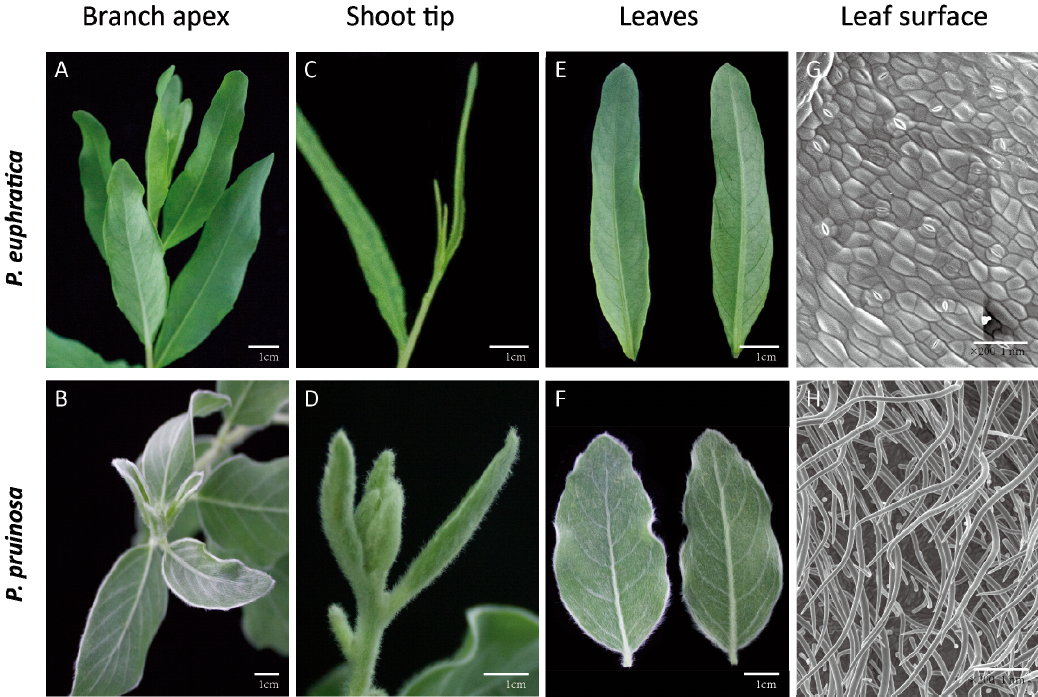
Figure 1. Trichome phenotypes of P. pruinosa and P. euphratica . An absence of trichomes was observed on P. euphratica branch apices, shoot tips and leaves ( A , C , and E ); while dense trichomes were seen on P. pruinosa ( B , D , and F ); Scanning electron microscopy ( G , H ) images of leaves from P. pruinosa and P. euphratica , respectively. Trichomes with a glabrous phenotype were observed in P. euphratica .